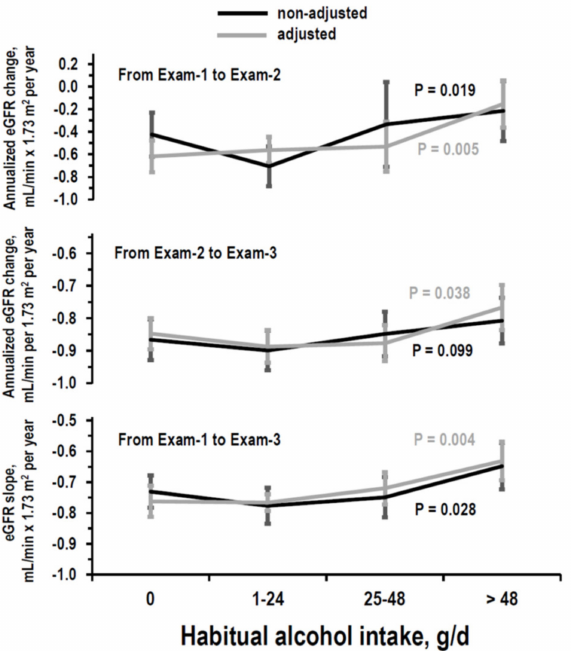
Figure 6. Longitudinal analyses: mean and 95%CI of annualized eGFR change from Exam-1 to Exam-2 by stratum of alcohol intake (g/d = g/day) at Exam-1, of annualized eGFR change from Exam-2 to Exam-3 by stratum of alcohol intake at Exam-2, and of eGFR slope over time from Exam-1 to Exam-3 by stratum of mean alcohol intake during follow-up in non-adjusted ANOVA (black